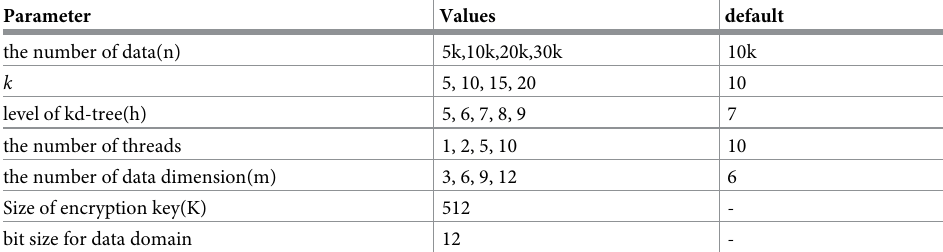
Table 4. Parameters used in performance evaluation for synthetic data.